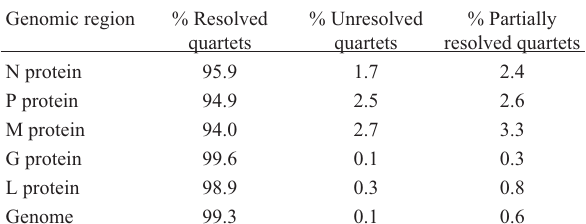
Table 3 - Description of the phylogenetic signal found for each RABV gene and for the complete genome using the quartet method.